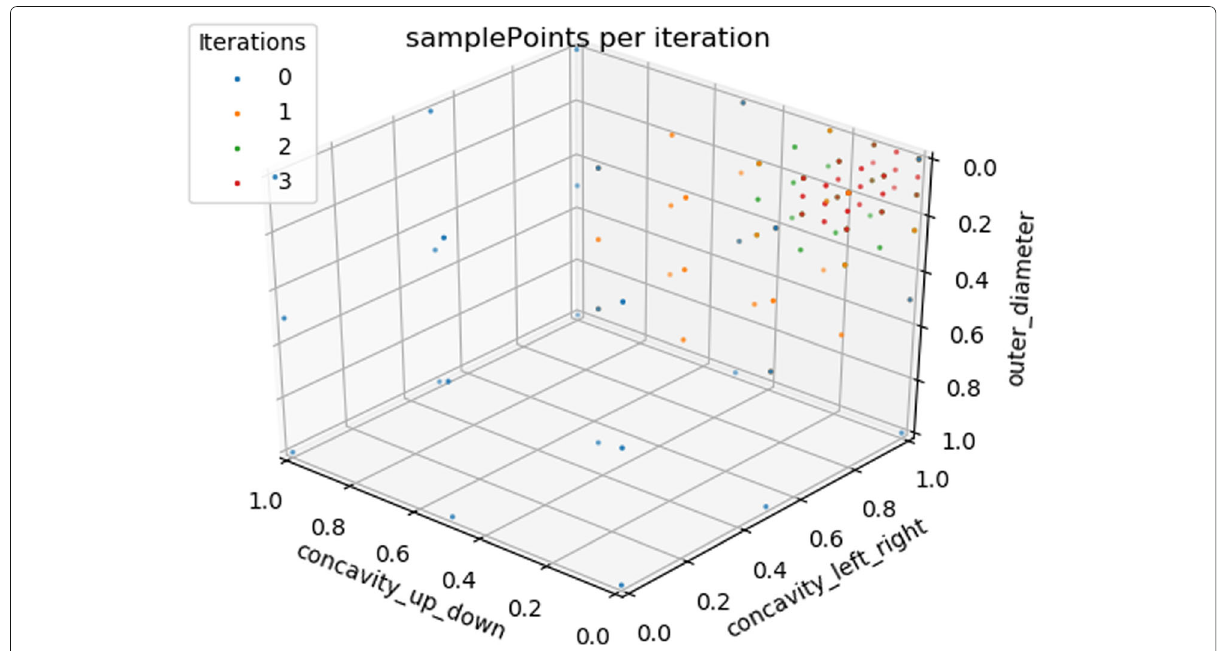
Fig. 20 Traversal of the parameter space